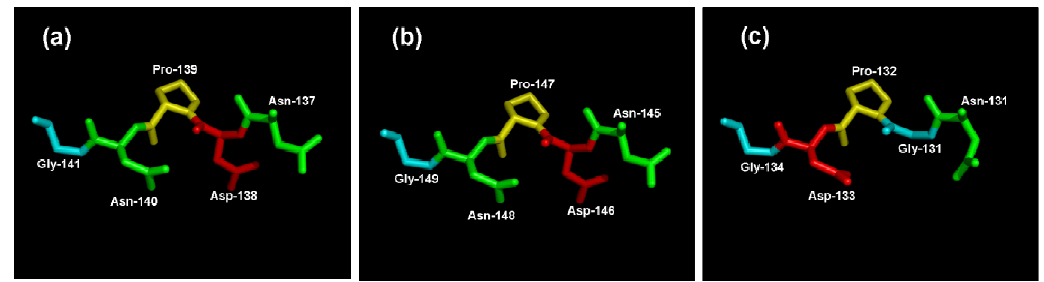
Figure 8. The close-up views of the NDPNG and NGPDG residue structure. ( a ) the structure of NDPNG within MeVINV1; ( b ) the structure of NDPNG within MeVINV2; ( c ) the structure of NGPDG within